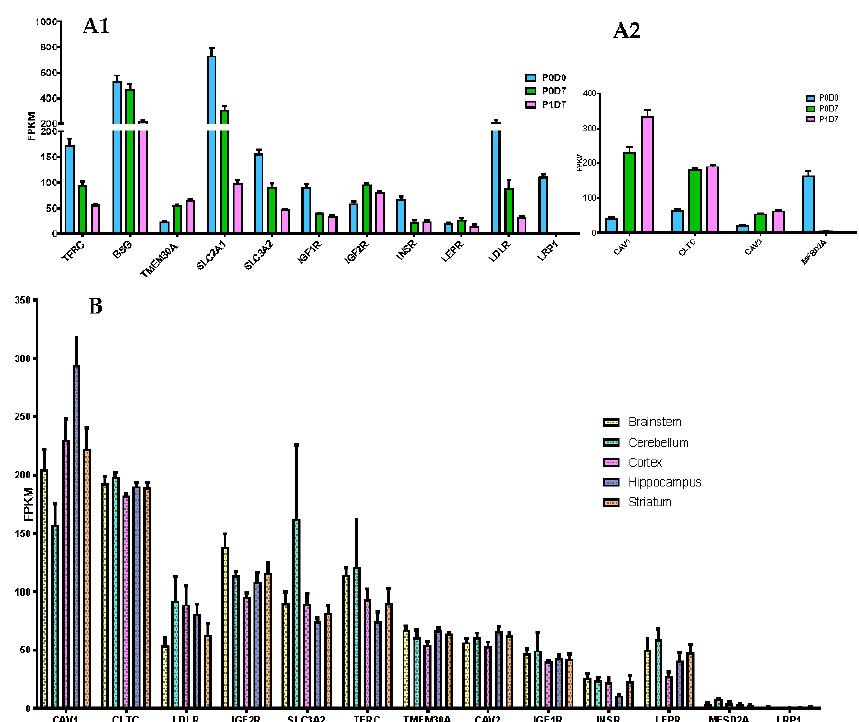
Figure 3. Expression of receptors capable of mediating transcytosis. ( A ) Comparison of the expression levels (FPKM) of selected receptors ( A1 ) and key internalization pathway genes ( A2 ) present in the brain microvascular P0D0, P0D7 and P1D7 fractions. Results represent average FPKM and are expressed and mean ± SD ( n = 6–8). ( B ) Comparison of the expression levels (FPKM) of selected receptors and key internalization pathway genes present in the brain microvascular endothelial cells from di ff erent brain regions. Results represent average FPKM and are expressed and mean ± SEM ( n = 2–8).